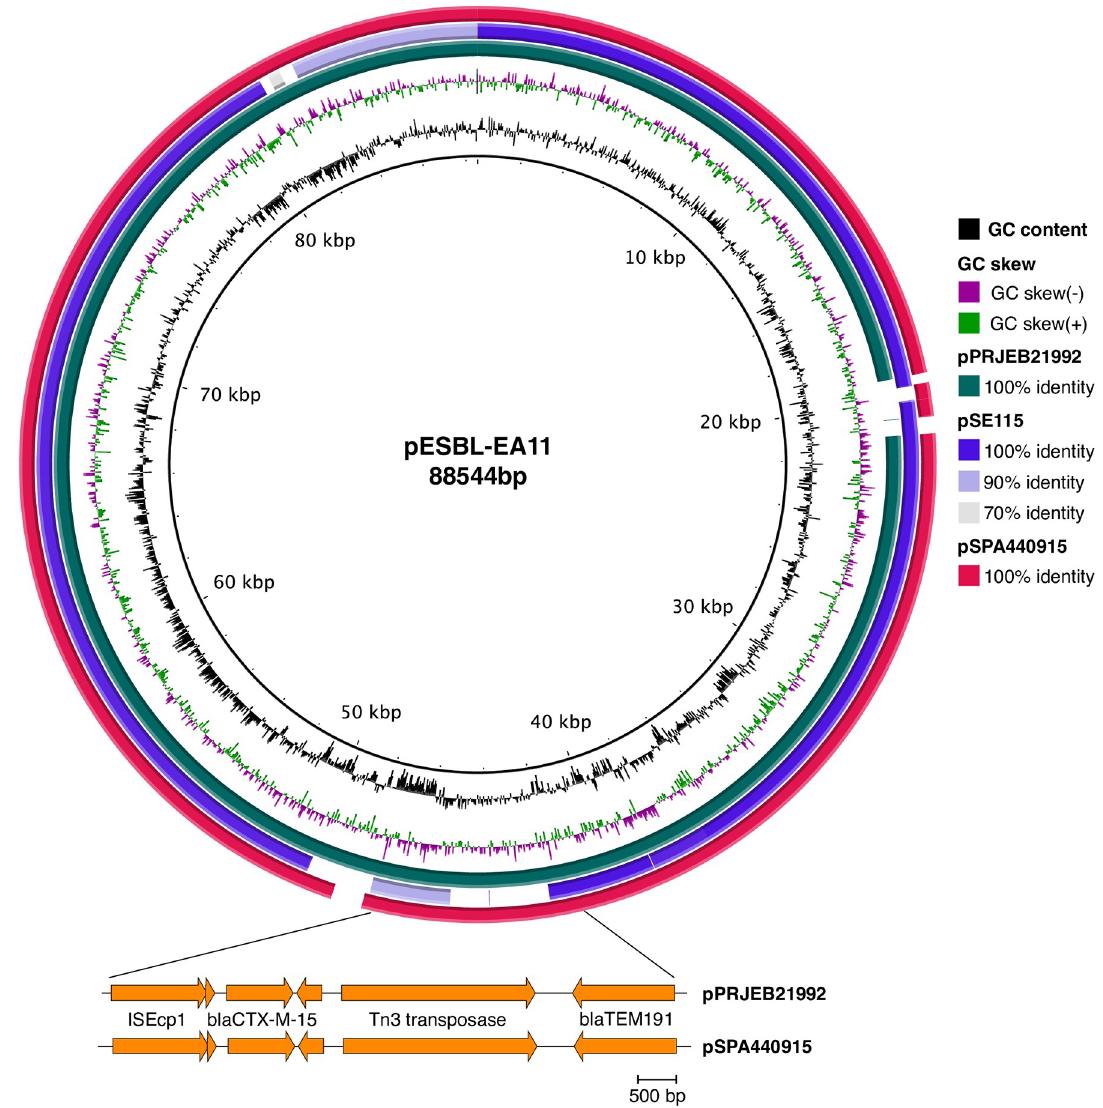
(purple): S . Enteritidis plasmid pSE115; ring 5 (red): S . Paratyphi A plasmid pSPA440915. Expanded region (genes in orange) indicating presence of beta lactamases, drawn using Easyfig [35]. Presence of ESBL mobile drug cassette ISEcp1, bla CTX-M-15 and bla 191 in both the Bangladesh S . Typhi and S . Paratyphi A 440915